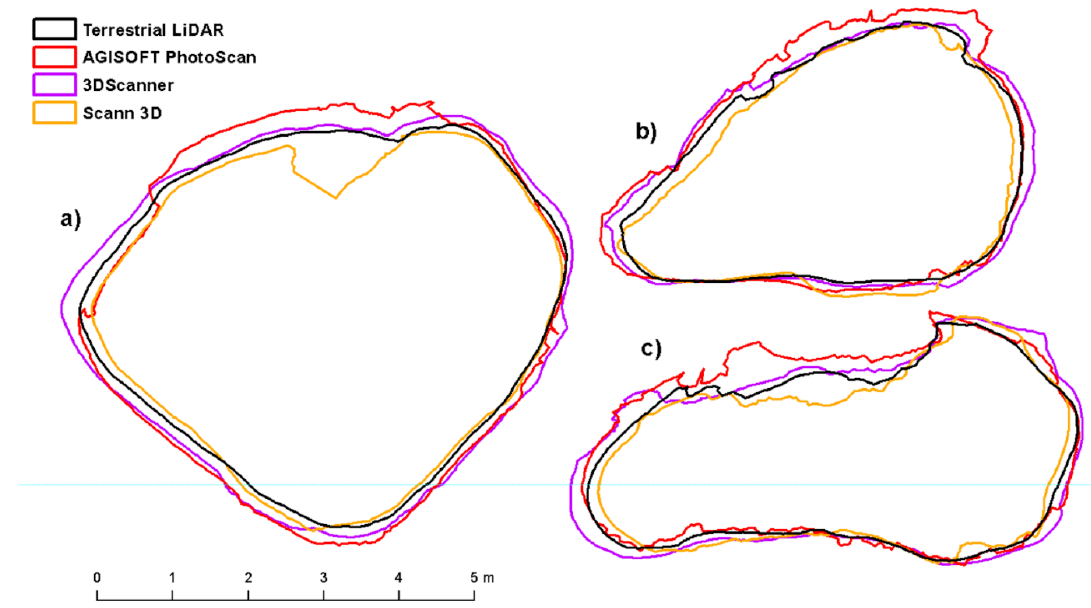
Figure 11. Shapes in cross sections boulder No. 2 (a-X axis, b-Y axis, c-Z axis).